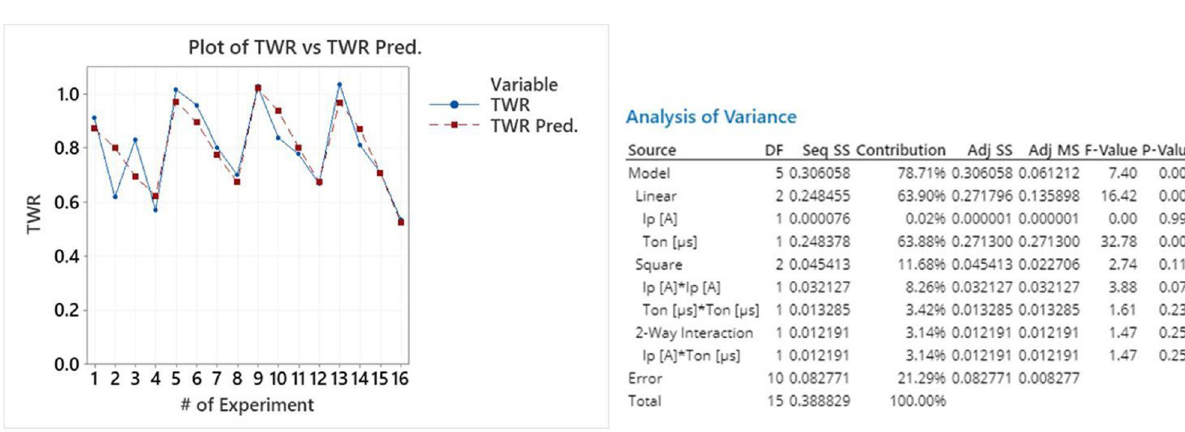
Figure 8. Plot of TWR vs TWR predicted and the model’s